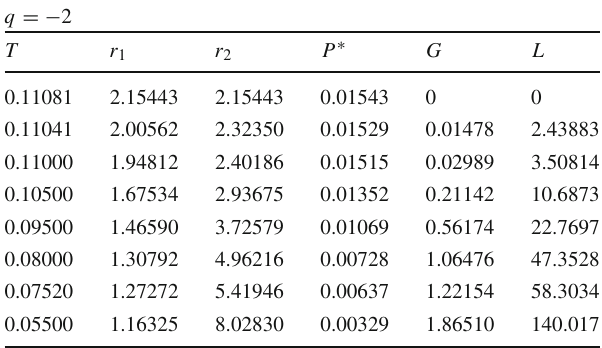
Table 1 The numericalresultsof theMaxwellequal arealawEqs. (3.3) and(3.10), theGibbsfreeenergyEq.(3.7), andthelatentheatEq.(3.11) for the hairy black hole with the spherical symmetry in the absence of a Maxwell field